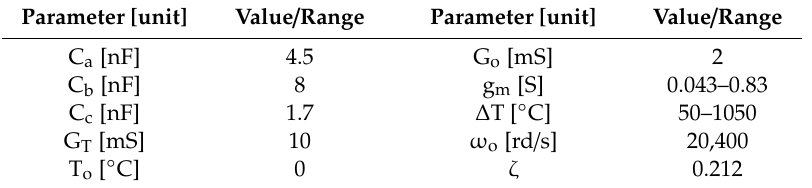
Table 2. Parameters of real temperature measurement line for oscillating second-order inertial transmitter.